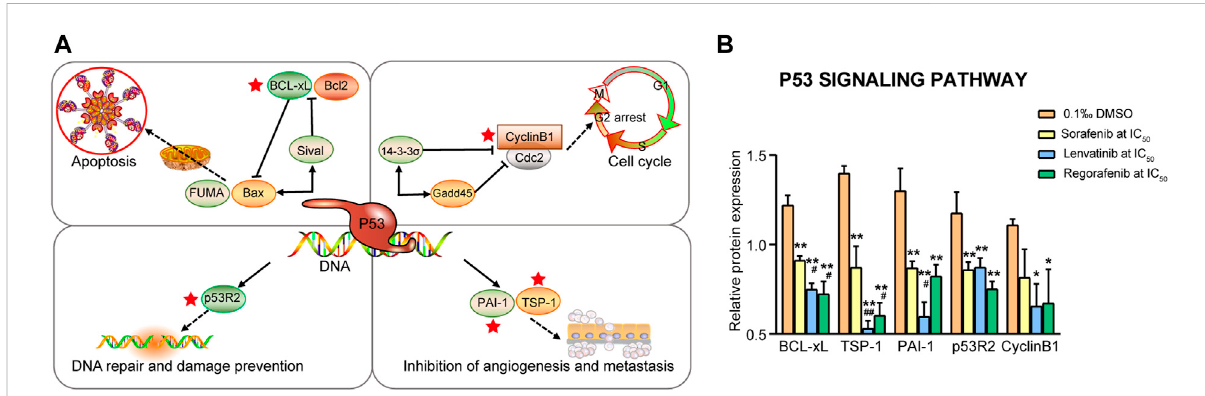
FIGURE 7 Commonly downregulated proteins involved in the p53 signaling pathway (A) and their relative expression (B) in Huh-7 cells treated by 72 h incubation with respective sorafenib, lenvatinib and regorafenib. Each bar presents mean ± SD ( n = 3). The * p < 0.05 and ** p < 0.01 versus DMSO;